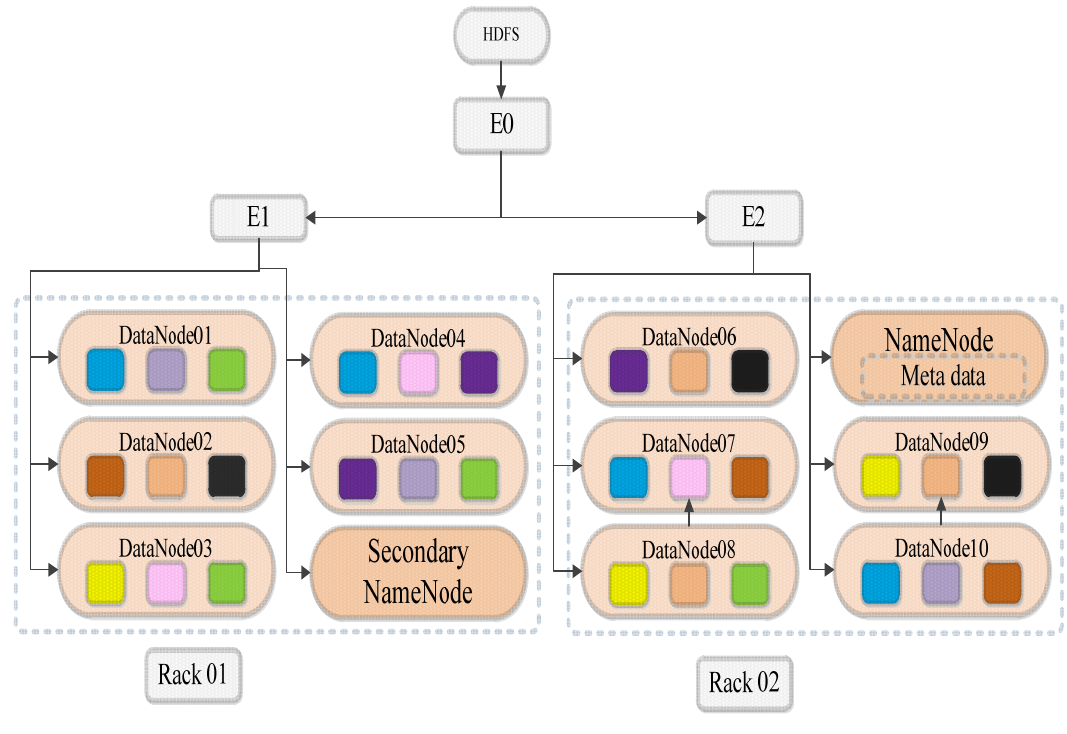
Figure 9. Architecture of HDFS.